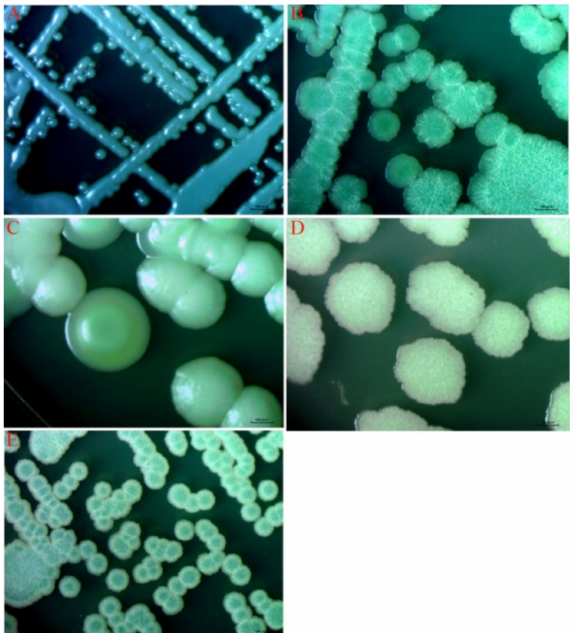
Figure 2. Photographs of yeast colony morphotypes on WL nutrient agar. ( A ) Colony morphotypes of Metschnikowia sinensis ; ( B ) Colony morphotypes of Wickerhamomyces anomalus ; ( C ) Colony morpho- types of Hanseniaspora gulliermondii ; ( D ) Colony morphotypes of Torulaspora delbrueckii ; ( E ) Colony morphotypes of Pichia kluyveri . Scale bar = 100